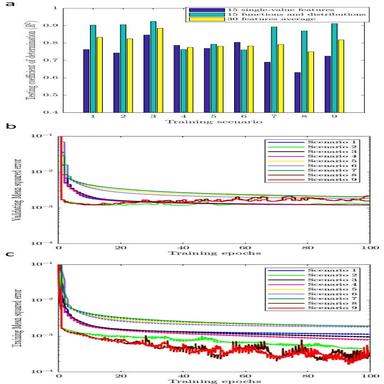
Comparing 9 training scenarios in terms of testing coefficients of determination (r-squared) (a), validating mean squared error per epoch (b), and training mean squared error per epoch (c).